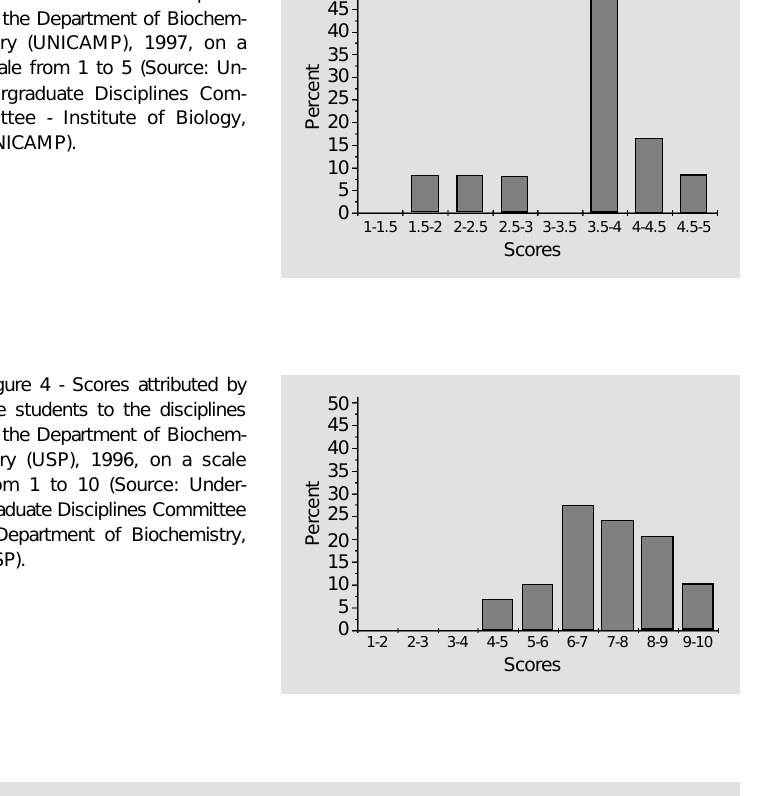
(Figure 3), and at USP, the discipline ob- tained a score of 9.0, being located among the best 9.4% (Figure 4).